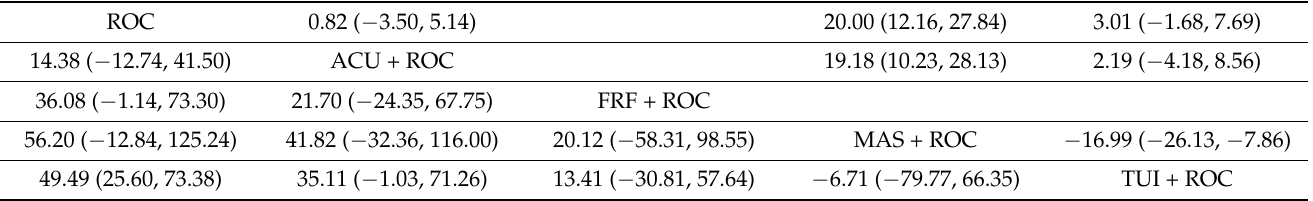
Table 4. Network league table of FEV1/FVC (%) (right upper part) and 6 min walking distance (m) (left lower part). ROC